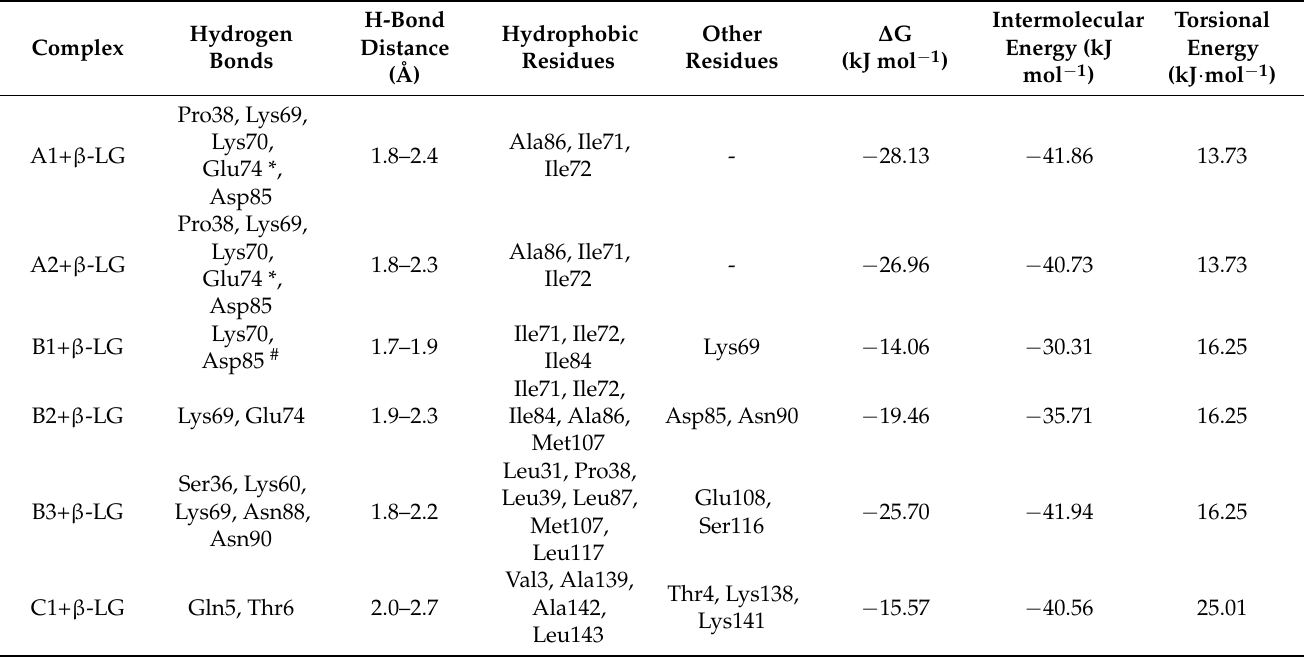
Table 5. Molecular docking parameters for proanthocyanidins binding to β -LG.